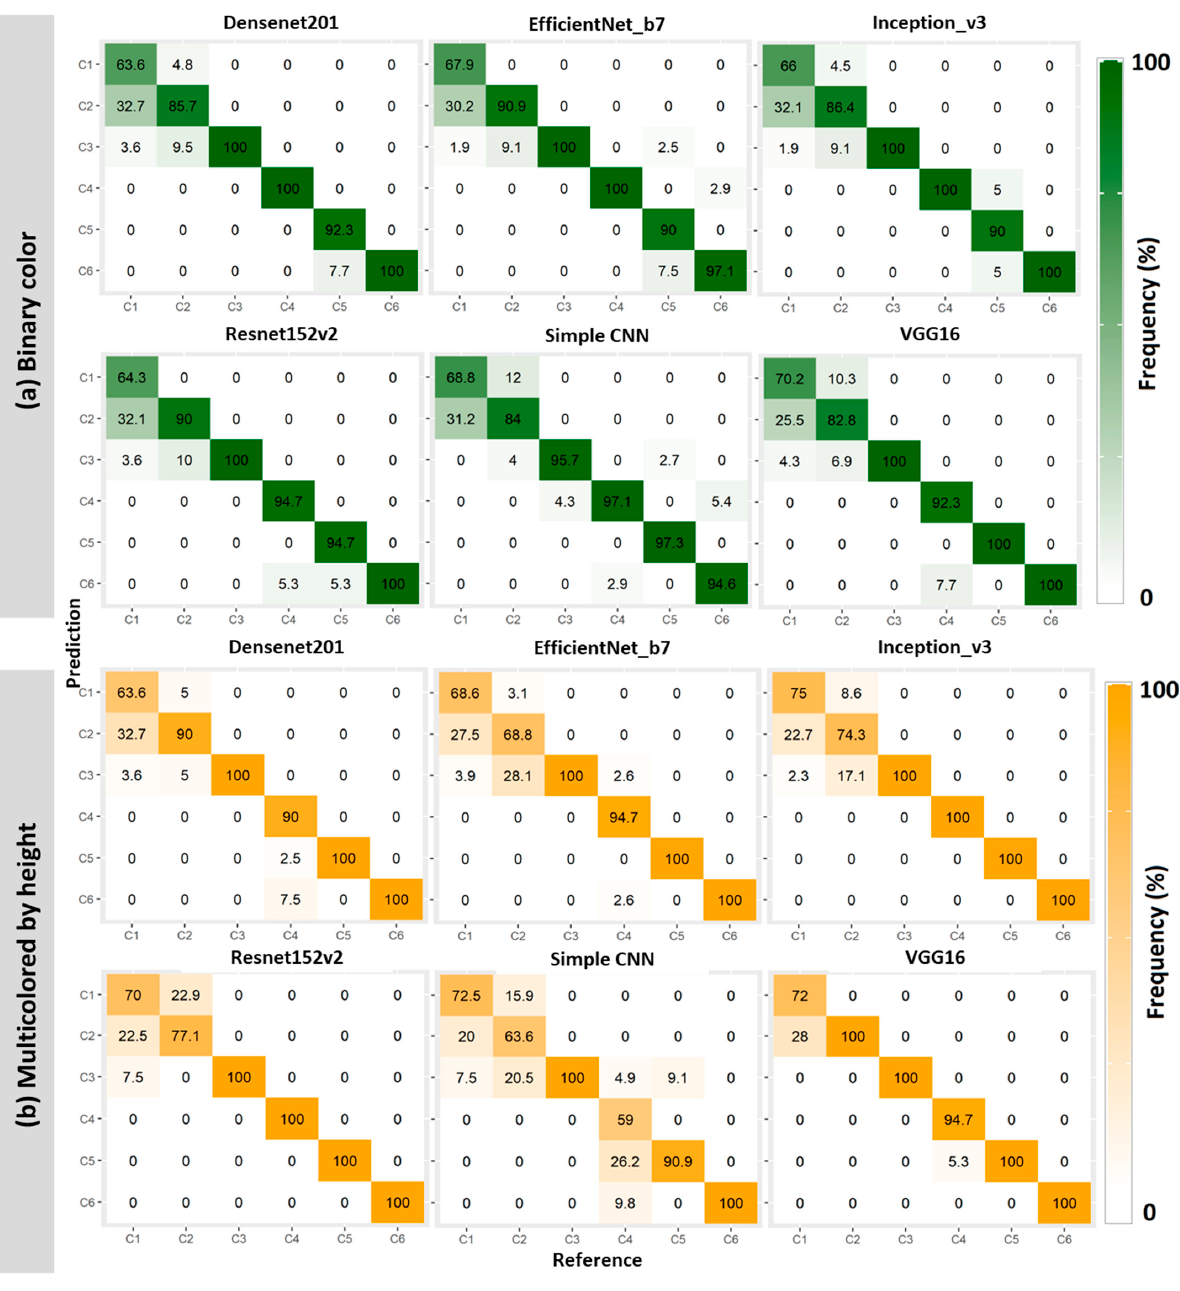
Figure 6. Confusion matrices derived from CNN architectures and TLS-derived 2D images in binary color ( a ) and multicolored by height ( b ). The percentage of misclassification between a pairwise combination of damaged trees is shown in the off-diagonal cells. Each cell contains absolute values (pixels) and relative